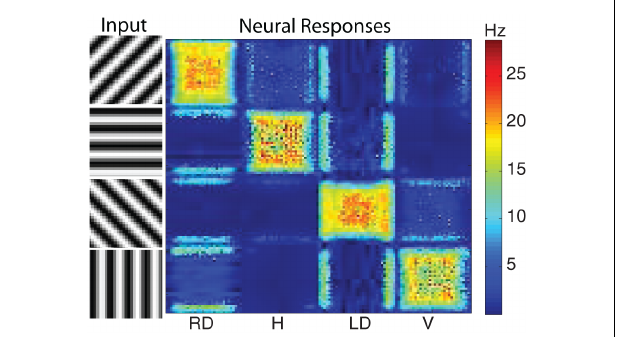
FIGURE 5 |The response of theV4 orientation filters to different oriented stimuli. The four stimuli presented to the network are shown on the left. On the right are the neural responses of the four different orientation populations: right diagonal (RD), horizontal (H), left diagonal (LD), and vertical (V). Each population has 1024 neurons (32 by 32) and the firing rate of each neuron is shown in pseudo-color with blue being no response and red being high response.The corresponding firing rates are given by the color bar to the right of the neural populations. As one can see the strongest activity of each population corresponds to the stimuli corresponding to its preferred